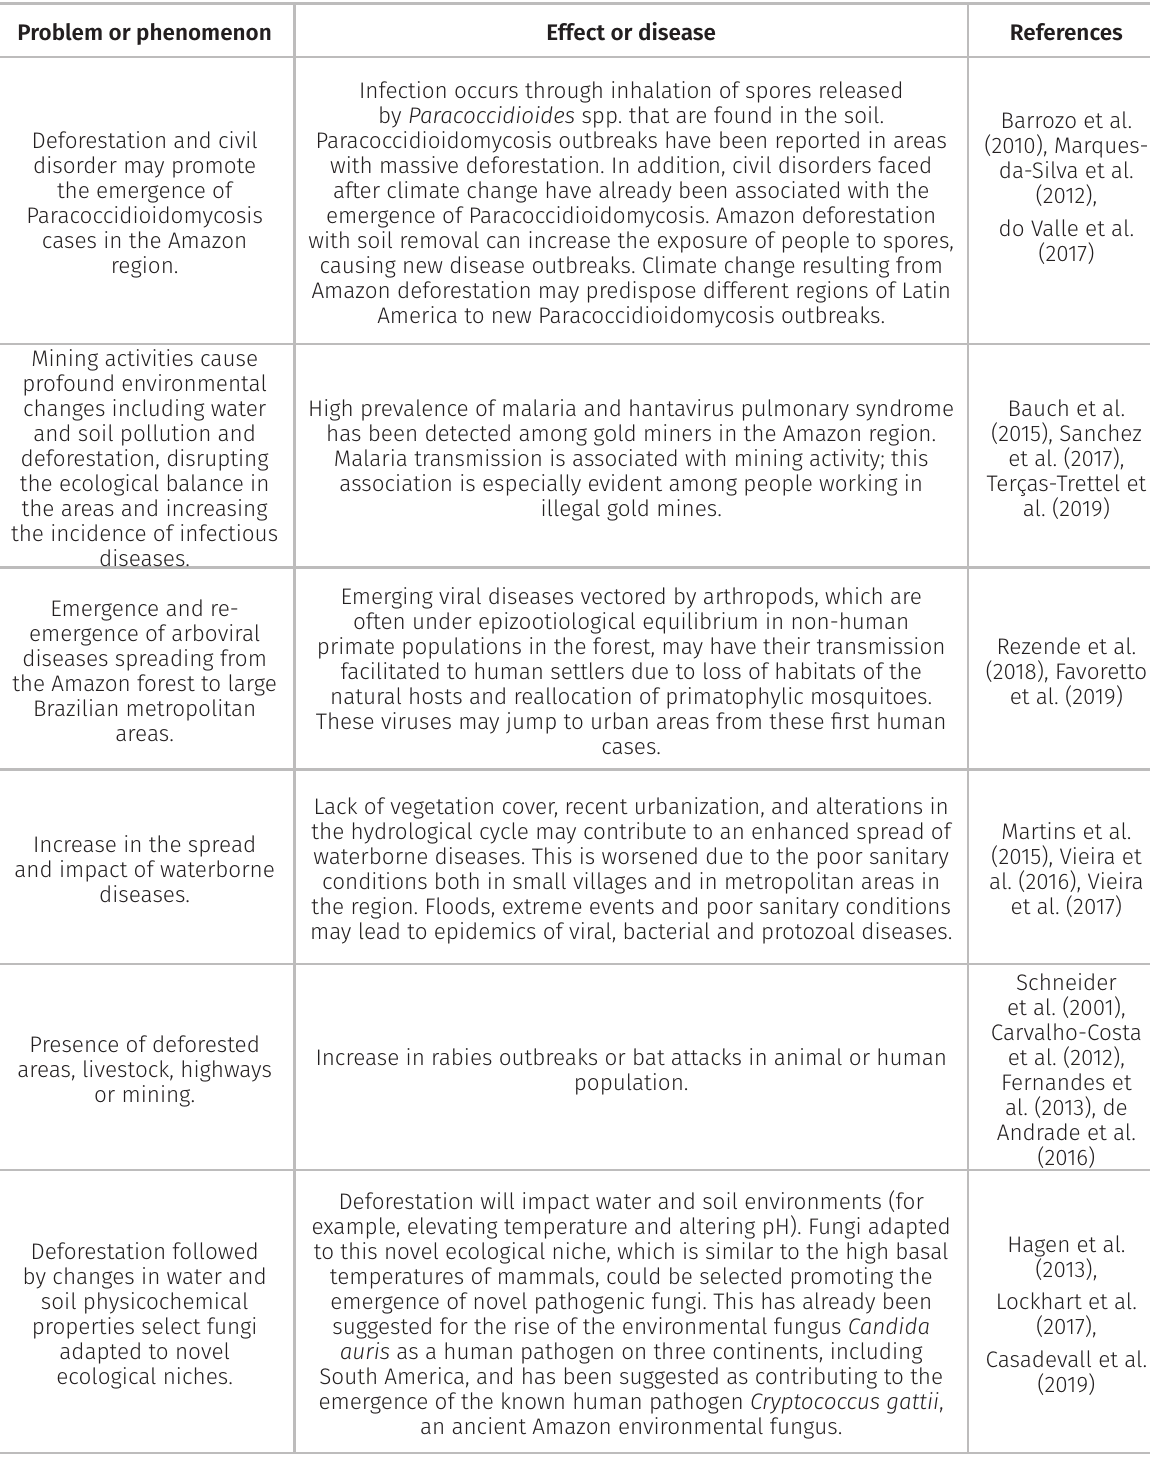
Table I. Selected examples of problems and phenomena associated with Amazon deforestation and their impacts on infectious